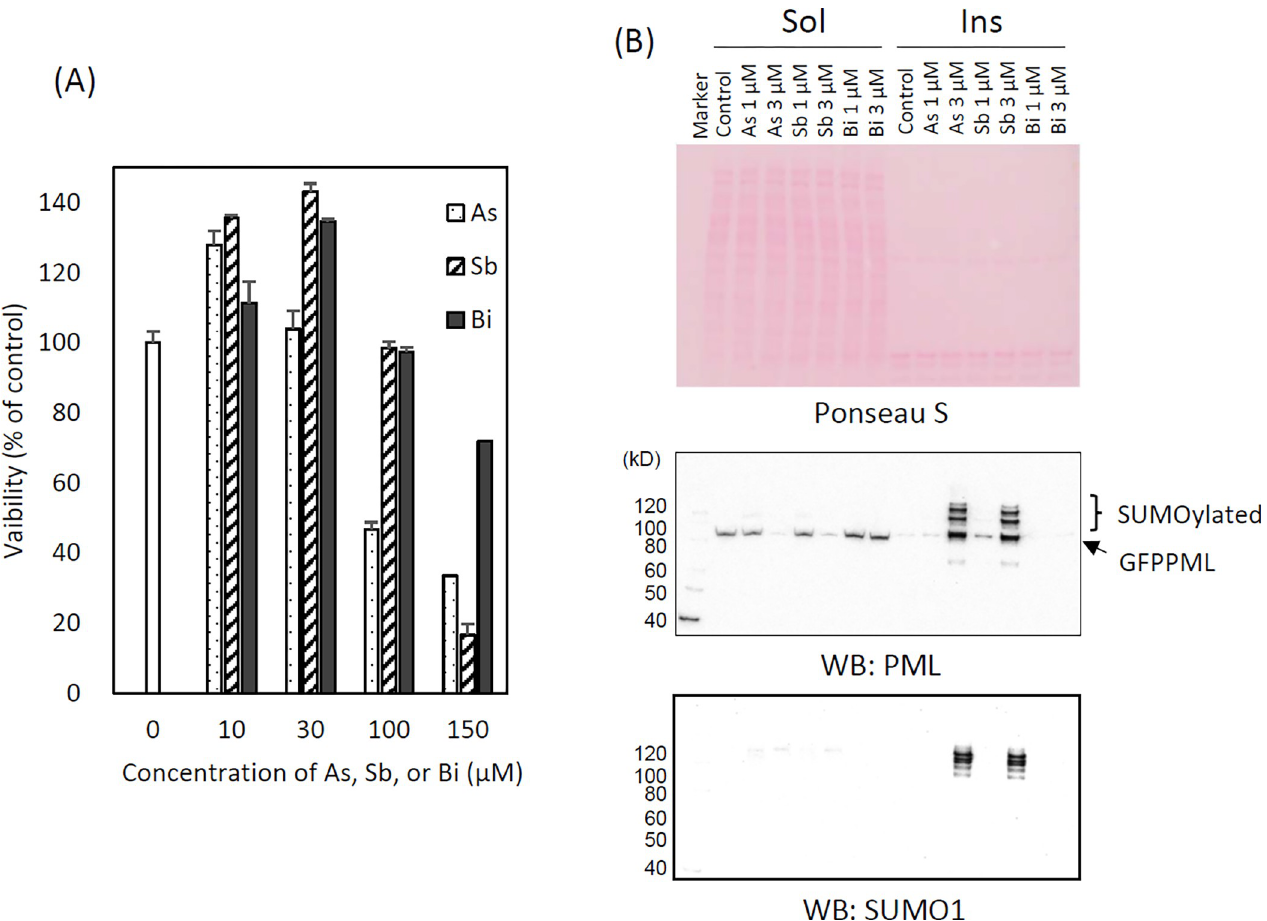
Fig 3. Changes in cell viability (A), and solubility shift and SUMOylation of PML (B) in response to trivalent arsenic (As), antimony (Sb), or bismuth (Bi) ions in CHOGFPPML cells. (A) The cells were exposed to various concentrations of As 3+ , Sb 3+ , or Bi 3+ for 24 h. As 3+ was significantly more cytotoxic than Sb 3+ and Bi 3+ in CHOGFPPML cells as analyzed by two–way ANOVA followed by Tukey’s multiple comparison. Data are presented as means ± SEM of quadruplicated wells. (B) The solubility of PML in cold RIPA buffer decreased in response to 2 h–exposure to 1–3 μ M As 3+ or Sb 3+ . GFPPML was SUMOylated (SUMO1) following exposure to either 3 μ M As 3+ or Sb 3+ . These biochemical changes were not observed in Bi 3+ –exposed cells. The major cold RIPA–insoluble proteins observed by Ponseau S–staining are histones. ‘Sol’ and ‘Ins’ denote the RIPA–soluble and–insoluble fractions, respectively. soluble fraction at 1 h post-exposure in both CHOGFPPML (Fig 6A) and HEKGFPPML cells (Fig 6B). Accordingly, immunoprecipitation was performed using the RIPA-soluble fraction with magnetic bead-tagged anti-GFP antibody using the clear supernatants of RIPA lysates obtained from untreated and As 3+ -exposed (1 h) CHOGFPPML cells (Fig 7A) and HEKGFPPML cells (Fig 7B). Modification on GFPPML with SUMO2/3 and SUMO1, and ubi- quitination, were clearly observed in these cells after 1 h-exposure to As 3+ . It should be noted that the amount of SUMOylated GFPPML immunoprecipitated in the untreated cells was less than that of As 3+ -exposed cells.